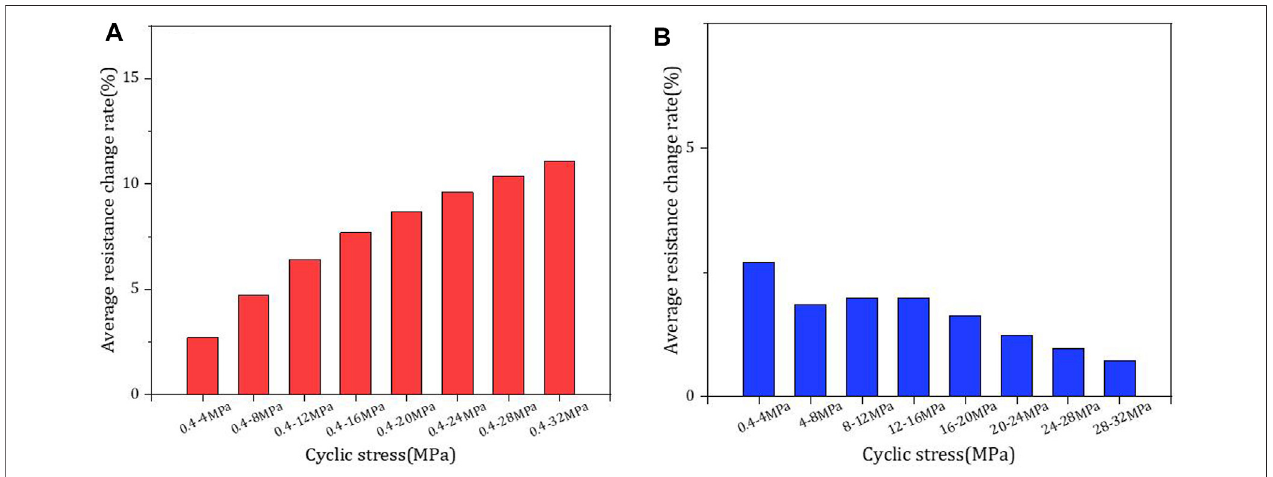
FIGURE 9 | The average resistance change rate: (A) under cyclic loading for different amplitudes; (B) under sustained cyclic loading.